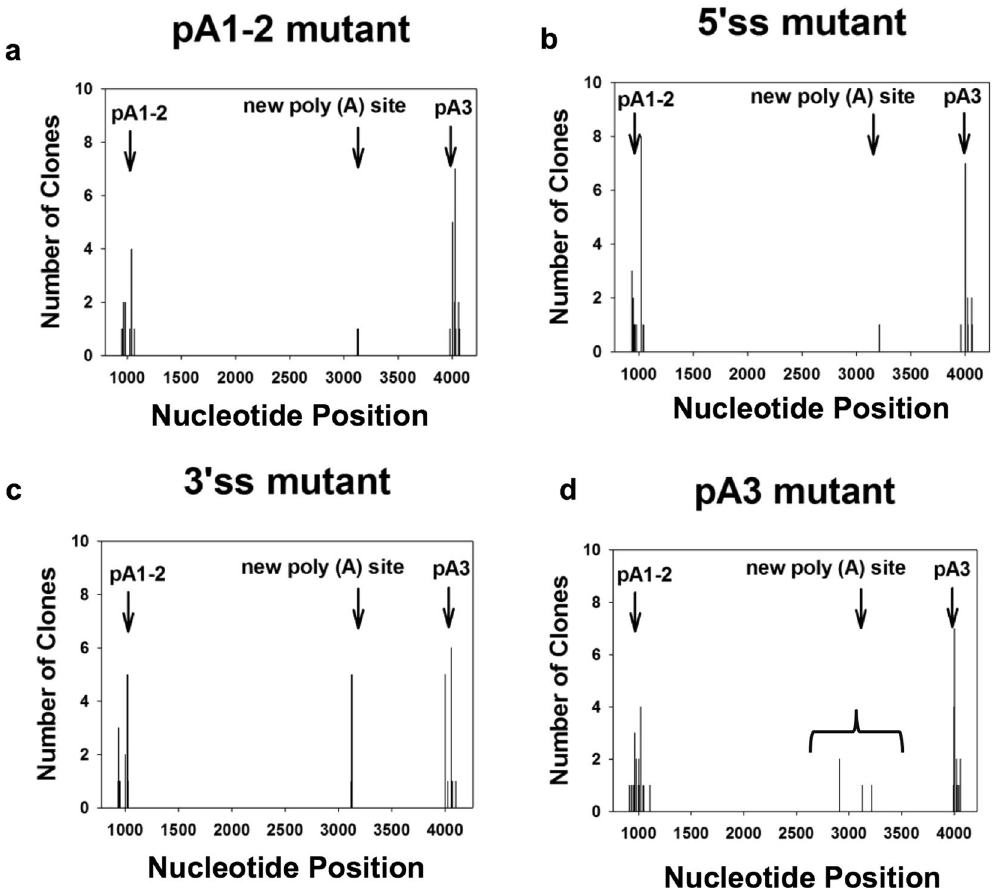
Figure 5. Poly(A) sites detected in OXT6 mutant transgenic lines. ( a–d ) Poly(A) sites detected by 3 ′ RACE performed with pA1-2, 5 ′ ss, 3 ′ ss and pA3 transgenic plants. Nucleotide position of OXT6 gene (start from ATG) is listed at X-axis, and number of clones polyadenylated at the specific nucleotide is marked by vertical bars at